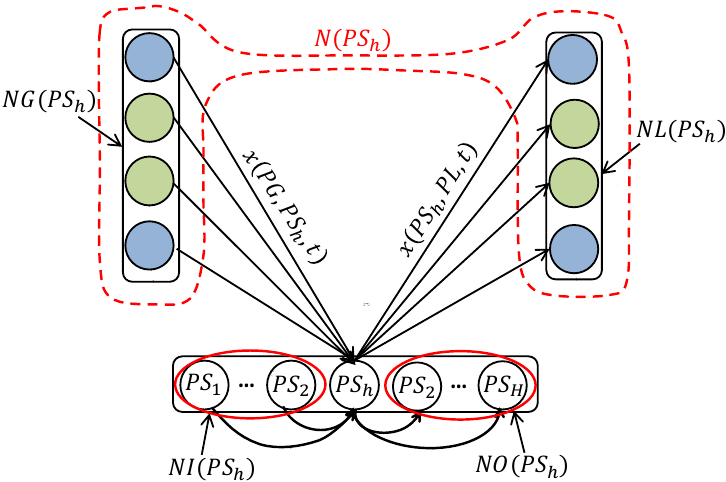
Figure 8. Power storages with neighboring devices and connections among